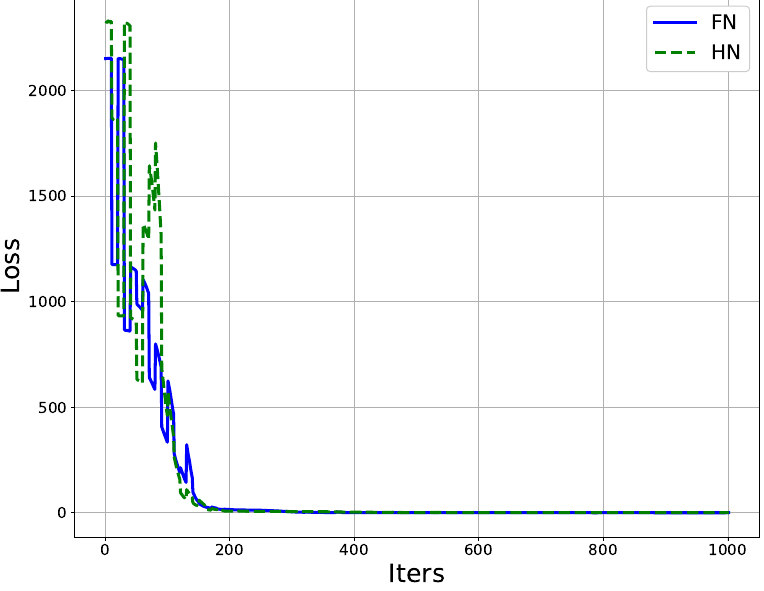
Figure 11. Loss function for the first iterations of the FN/HN